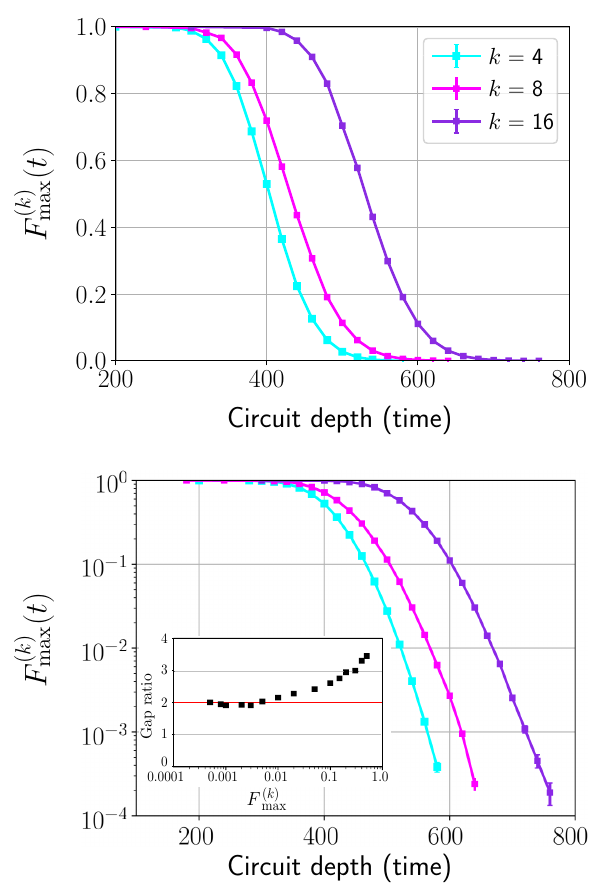
FIG. 7. A brute-force search over a wide class of k th-order OTOCs gives the maximum OTOC F ( k ) cise definition). We see that the k = 16 point function decays at a much later time in this case compared to the recursive OTOCs of the previous section. In the bottom plot, we show the same data on a logarithmic scale and define the scrambling time t ∗ time beyond which F ( k ) between scrambling times (cid:16) = ( t ∗ (cid:16) = 2 as (cid:12) → 0.